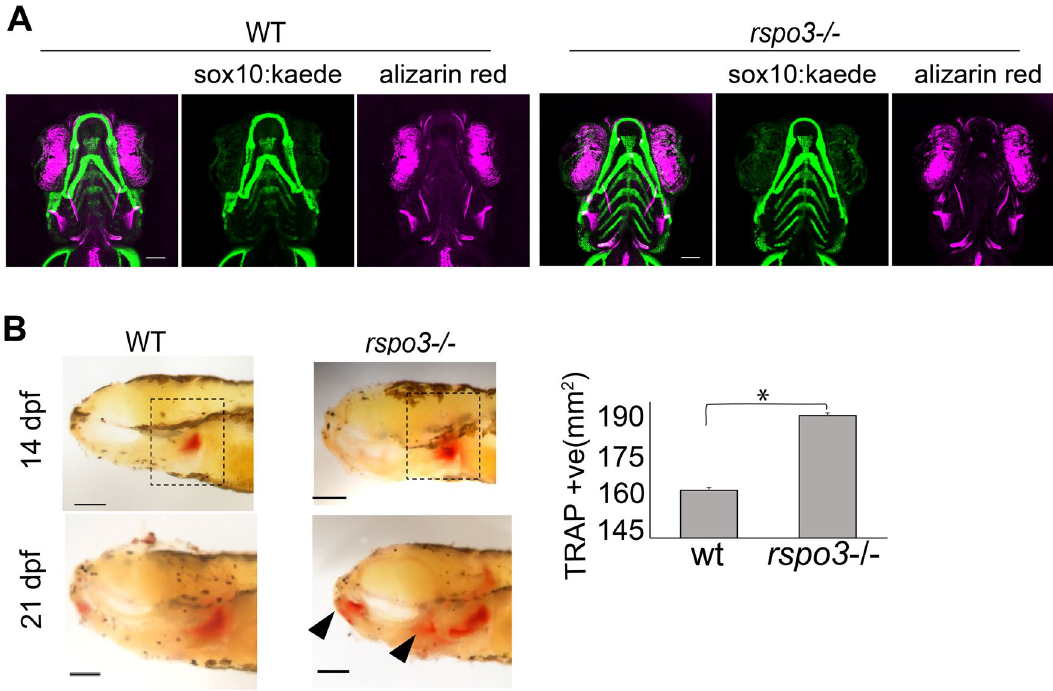
Figure 6. rspo3 ablation does not impact initial bone mineralization but increases osteoclast area of activity. ( A ) Representative images of maximum intensity projections of confocal z-stack of whole-mount 10 dpf zebrafish. Zebrafish express sox10:kaede transgene allowing fluorescent imaging of cartilage elements. Zebrafish were live- stained with Alizarin red S to visualize mineralized structures. No differences in intensity of Alizarin staining, elements stained, or cartilage architecture were noted in the rspo3 −/− fish. Scale bar: 100 μm. ( B ) Lateral view of 14 dpf showing increased osteoclast activity (red stain in the black dotted box) in rspo3 mutant as compared to wild-type. At 21 dpf, more areas of osteoclast activity in the dentary, hyomandibular, pharyngeal teeth and jaws (solid arrow) were observed in rspo3 −/− compared to wild-type. Quantification of total area of red staining. P < 0.05. N = 5. Scale bar: 100